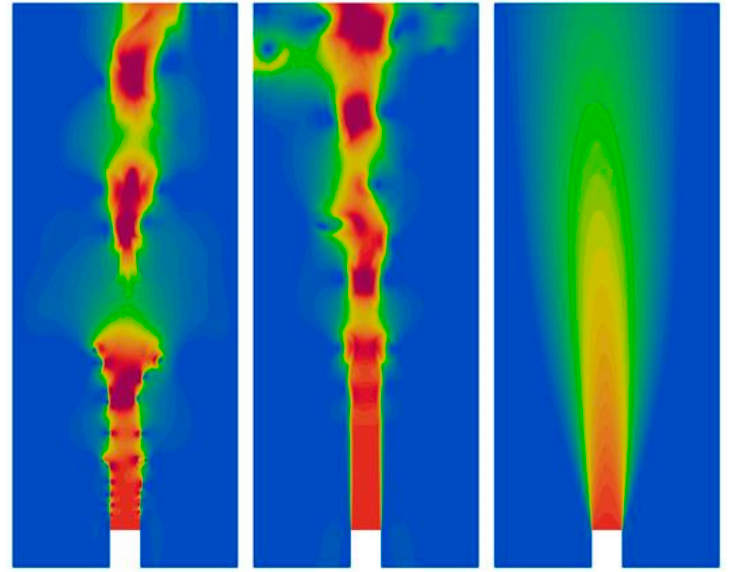
Figure 4. The results of the jet flow simulation using three methods: DNS, LES, and RANS - visualisation of flow velocity (from blue—lowest value, to red—highest value respectively).